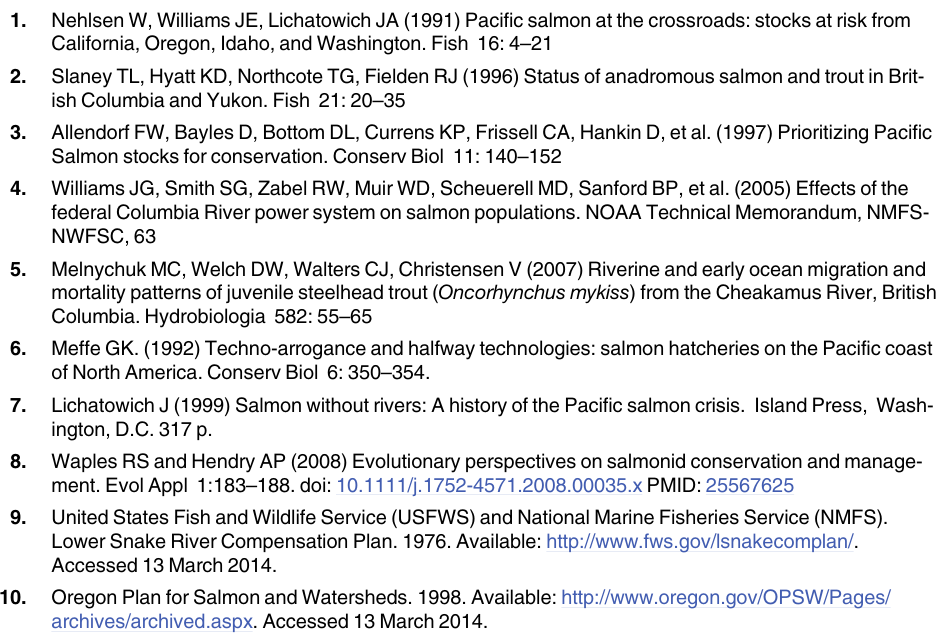
summarized by week. Dotted grey lines symbolize the bimodal distribution with a small